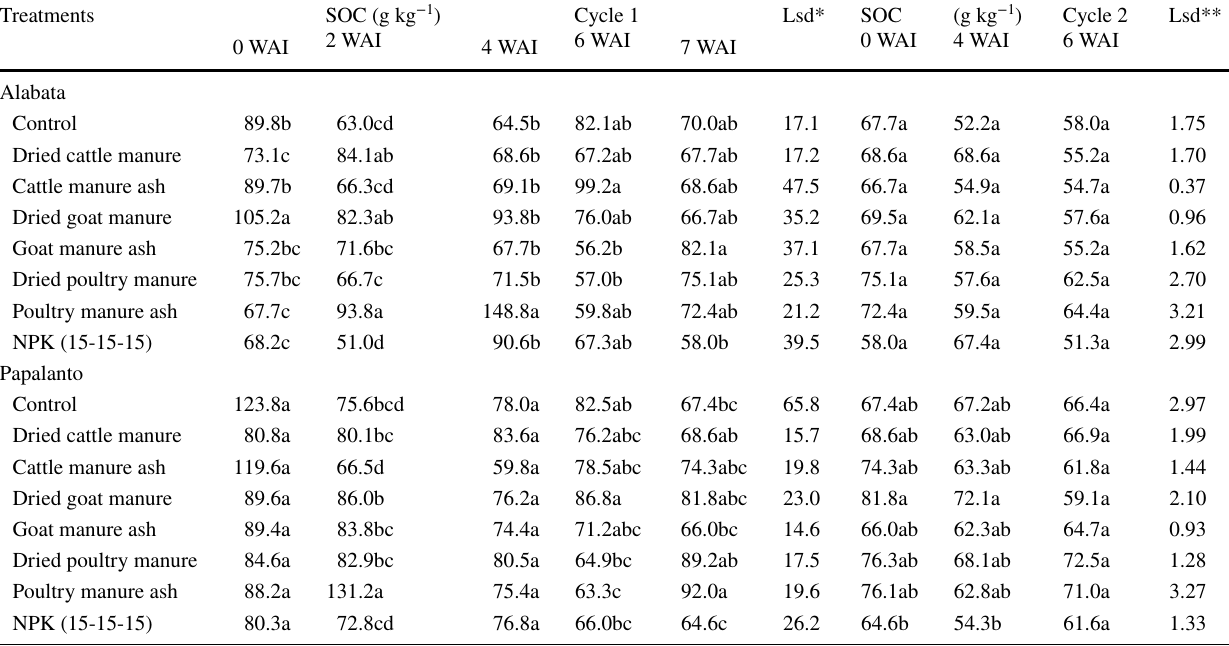
Table 4 Effect of amendments and time on organic carbon of soils from Alabata and Papalanto in screen-house experiment